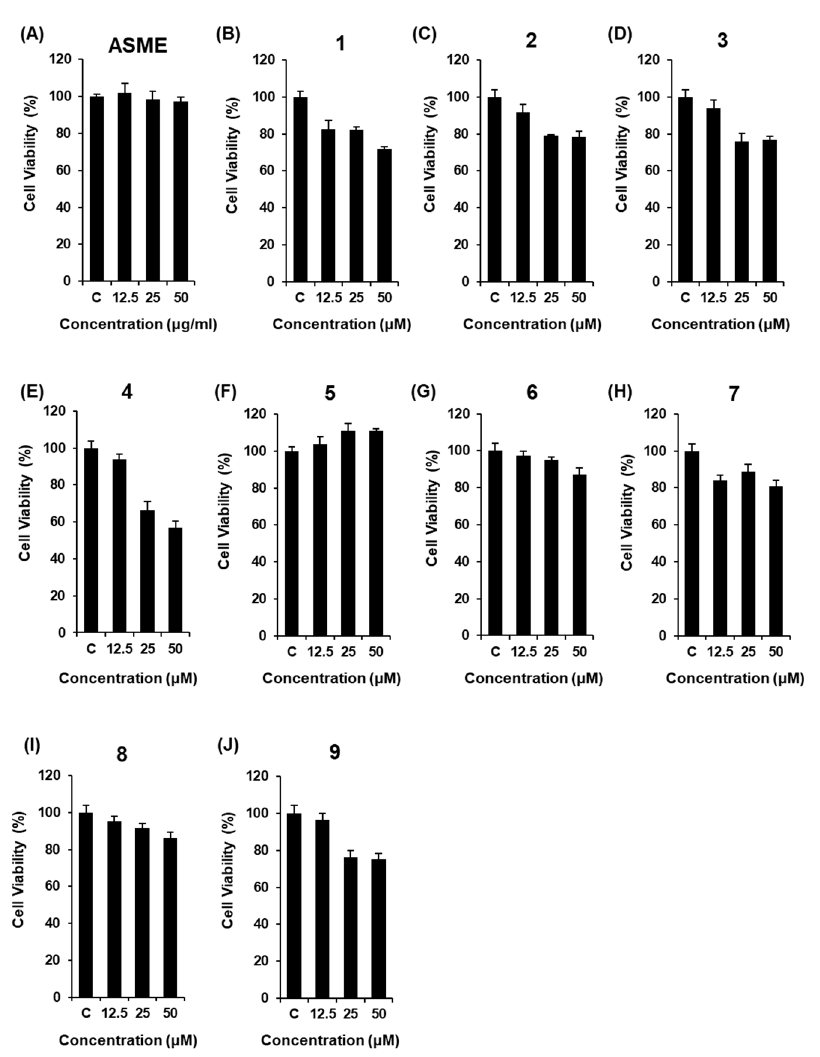
Figure 2. Effect of A. membranaceus extract (ASME) and compounds 1 – 9 isolated from A. membranaceus, on the viability of INS-1 cells. Effect of ( A ) ASME and ( B – J ) compounds 1 – 9 , compared with the control (0 μ g/mL), on the viability of INS-1 cells for 24 h by MTT assay.